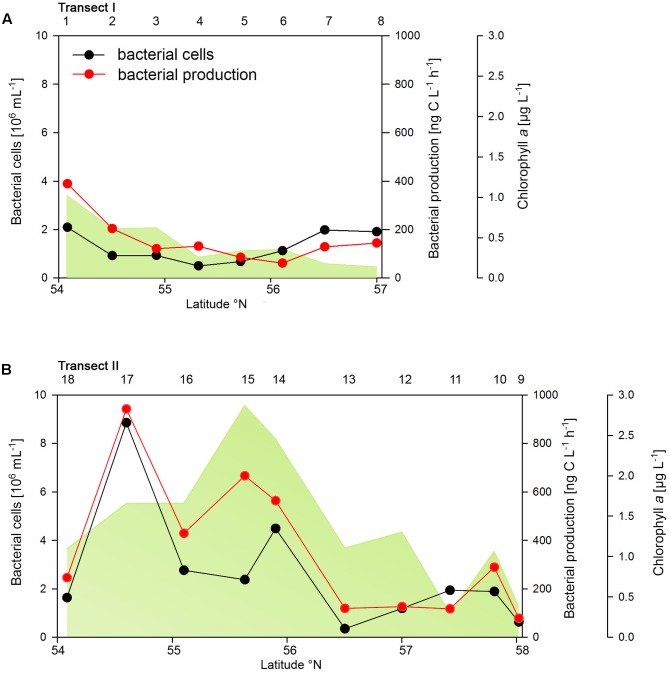
Bacterial cell numbers, biomass production and chlorophyll a concentrations measured spectrophotometrically of Transects I (A) and II (B) during early summer in the North Sea between 54° and 58°N. The numbers above the panels indicate station numbers.